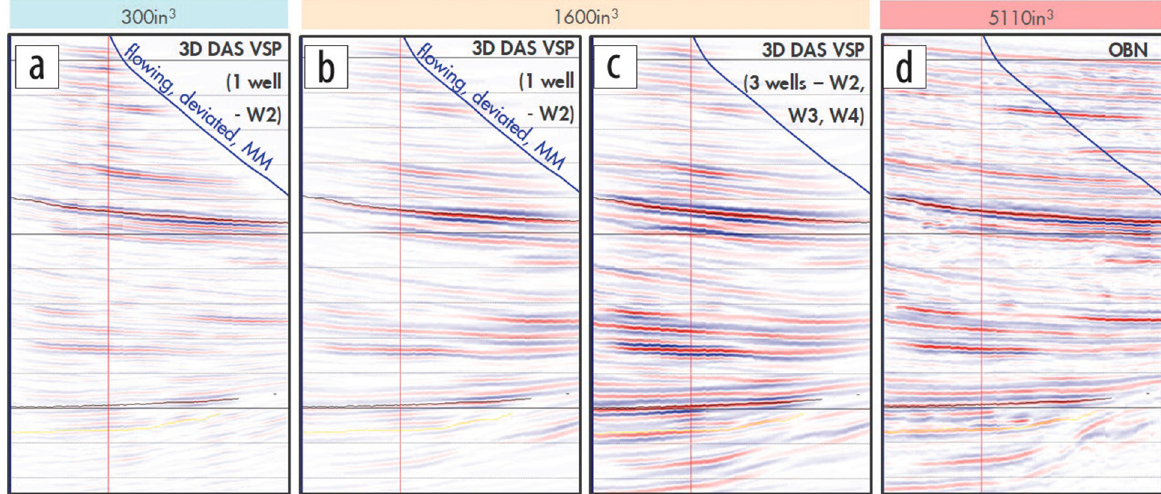
Figure 5. DAS-VSP conducted in flowing wells, with image quality as a function of acquisition efforts ( a ) Image obtained with a small seismic source recorded by a single DAS well. In ( b ), a larger source is deployed, improving the illumination of targets deep below the well. When the same source is recorded by three different DAS wells ( c ), the image extent and continuity are much improved. ( d ) a comparison to the costly alternative—an OBN survey with a very large seismic source. Figure from Kiyaschenko et al. (2020), The Leading Edge.